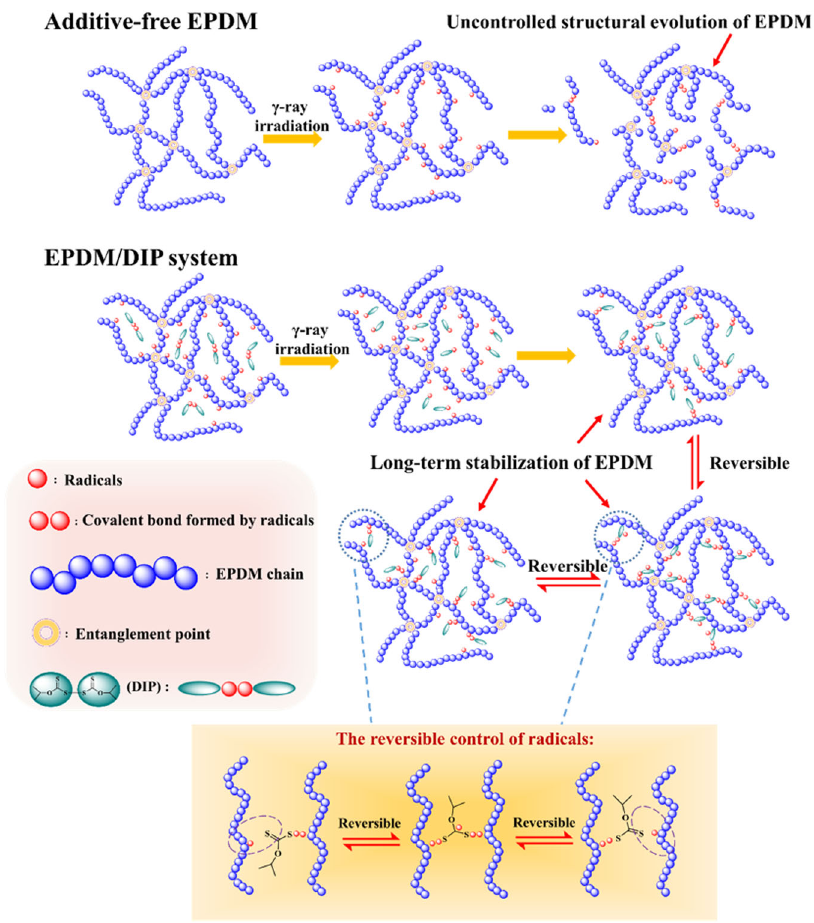
Fig. 12 Schematic illustration of the mechanisms through which DIP protects the EPDM during irradiation. Controllable structural evolution of EPDM under irradiation owing to the presence of DIP in the EPDM